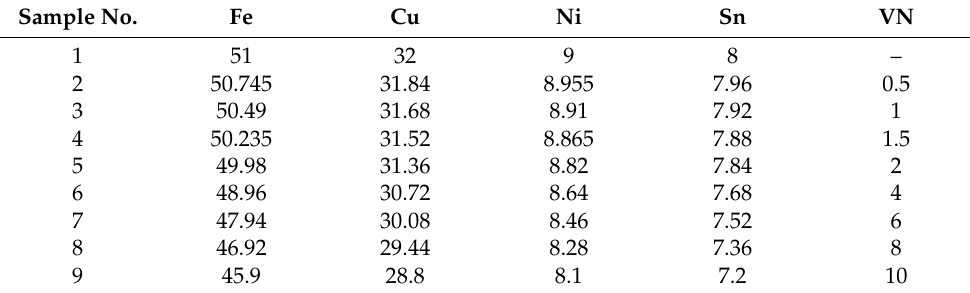
Table 1. Percentage of the components in the tested samples, wt.%. Sample